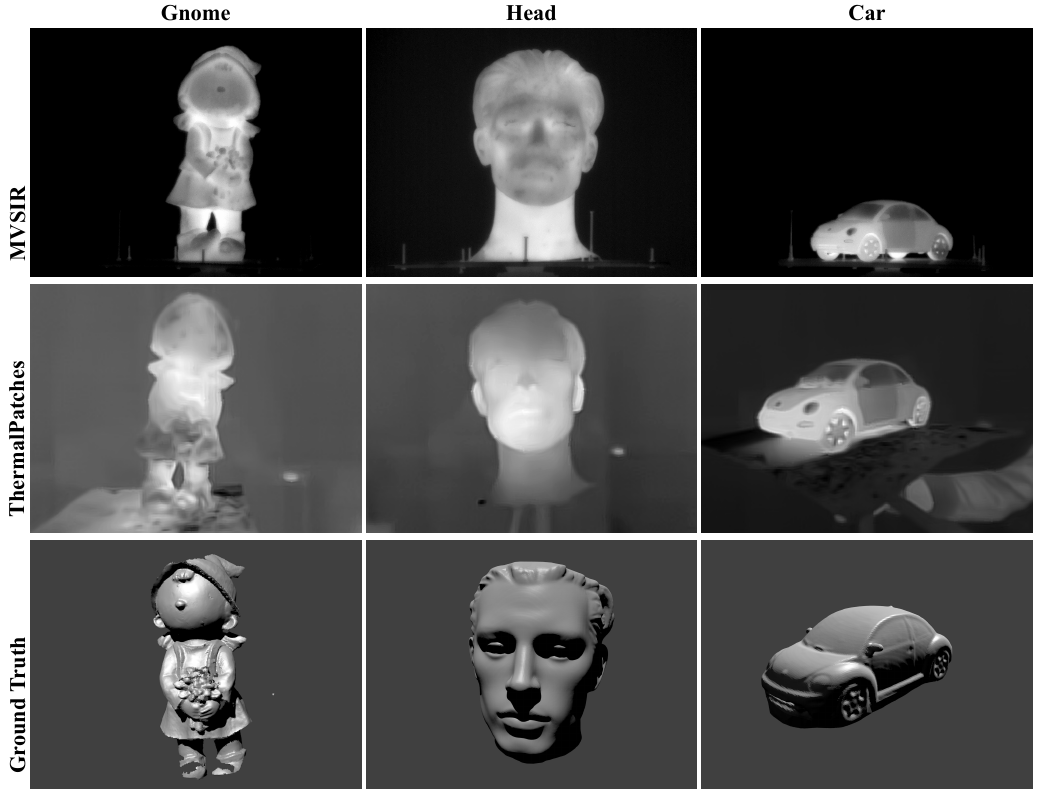
Figure 3. Comparing images from MVSIR and ThermalPatches datasets.